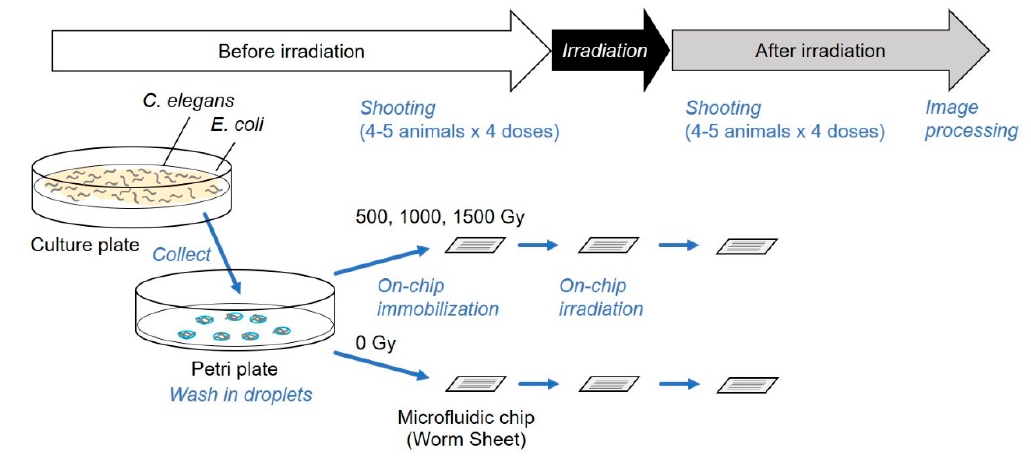
Figure 1. Schematic of the CNS-targeted irradiation of individual live C. elegans using a microfluidic chip. ( a ) Cross-sectional view of CNS-targeted irradiation of a live C. elegans enclosed in a microfluidic channel of a microfluidic chip. Anatomical structure of an individual C. elegans in the right panel was compiled with reference to a previous report [3]. ( b ) Schematic of a 300-µm, ultra-thin, ion-penetrable, wettable, microfluidic chip (Worm Sheet IR) enclosing live C. elegans individuals in the microfluidic channels. ( c ) Overhead view of the anterior body of an individual live C. elegans enclosed in a straight microfluidic channel of a microfluidic chip. The whole nerve ring in a ∅ ⌀ 60-µm micro-aperture region (filled in blue) or the center of the nerve ring (CNS) in a ⌀ 20-µm micro-aperture region (filled in yellow) were targeted and irradiated with an exact number of carbon ions.